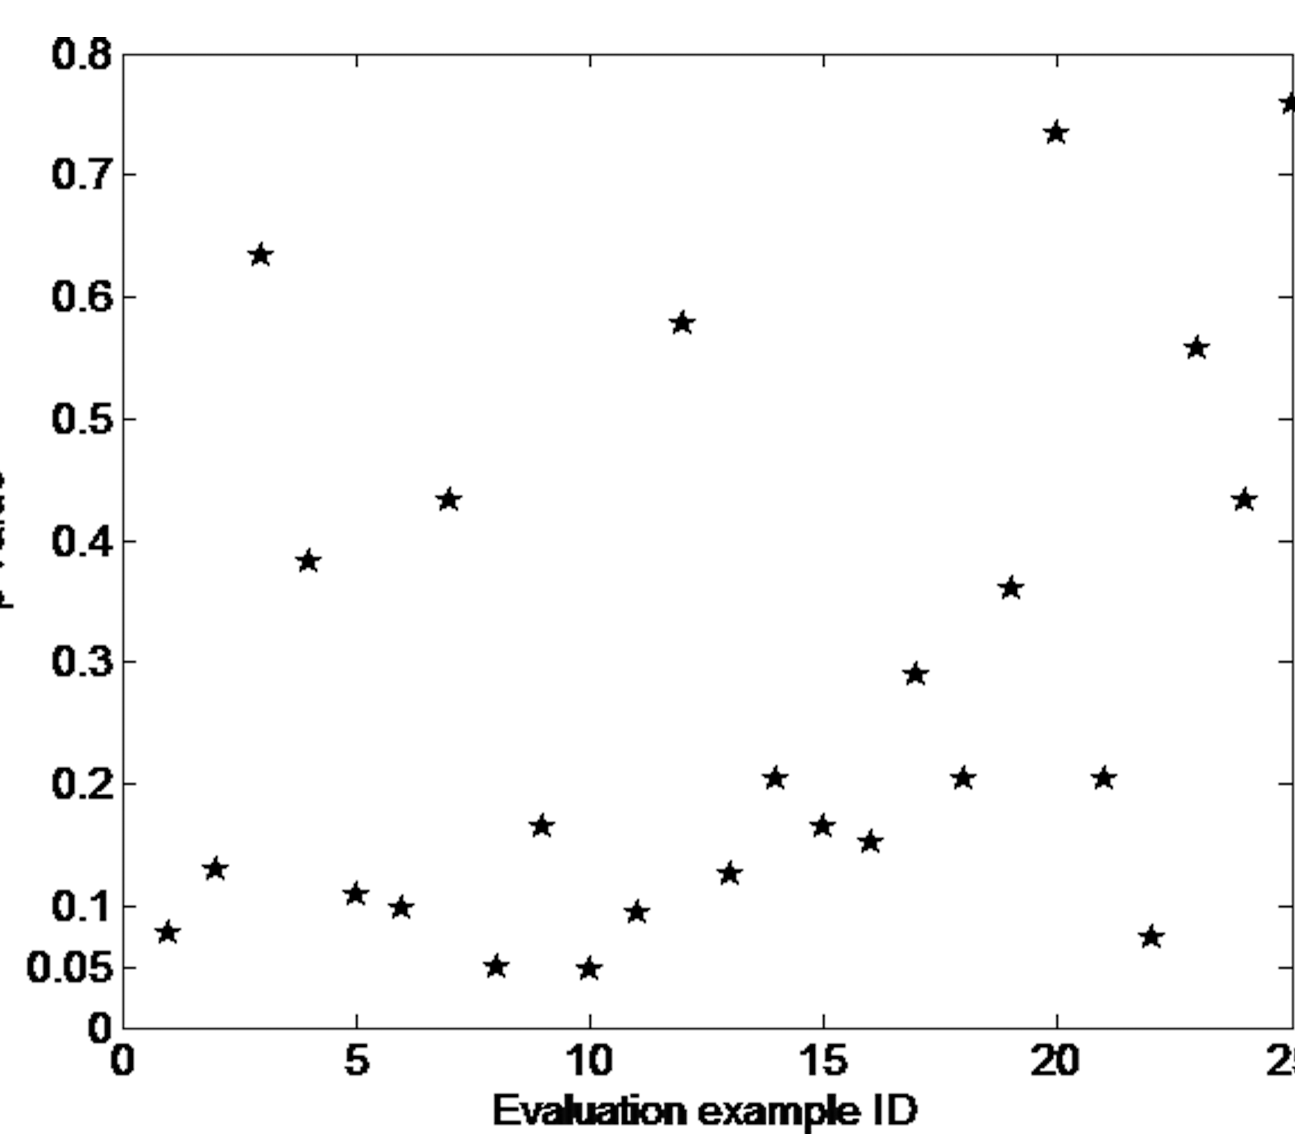
Fig 3. Scatter plot of p values obtained from clinical cervical cancer IMRT